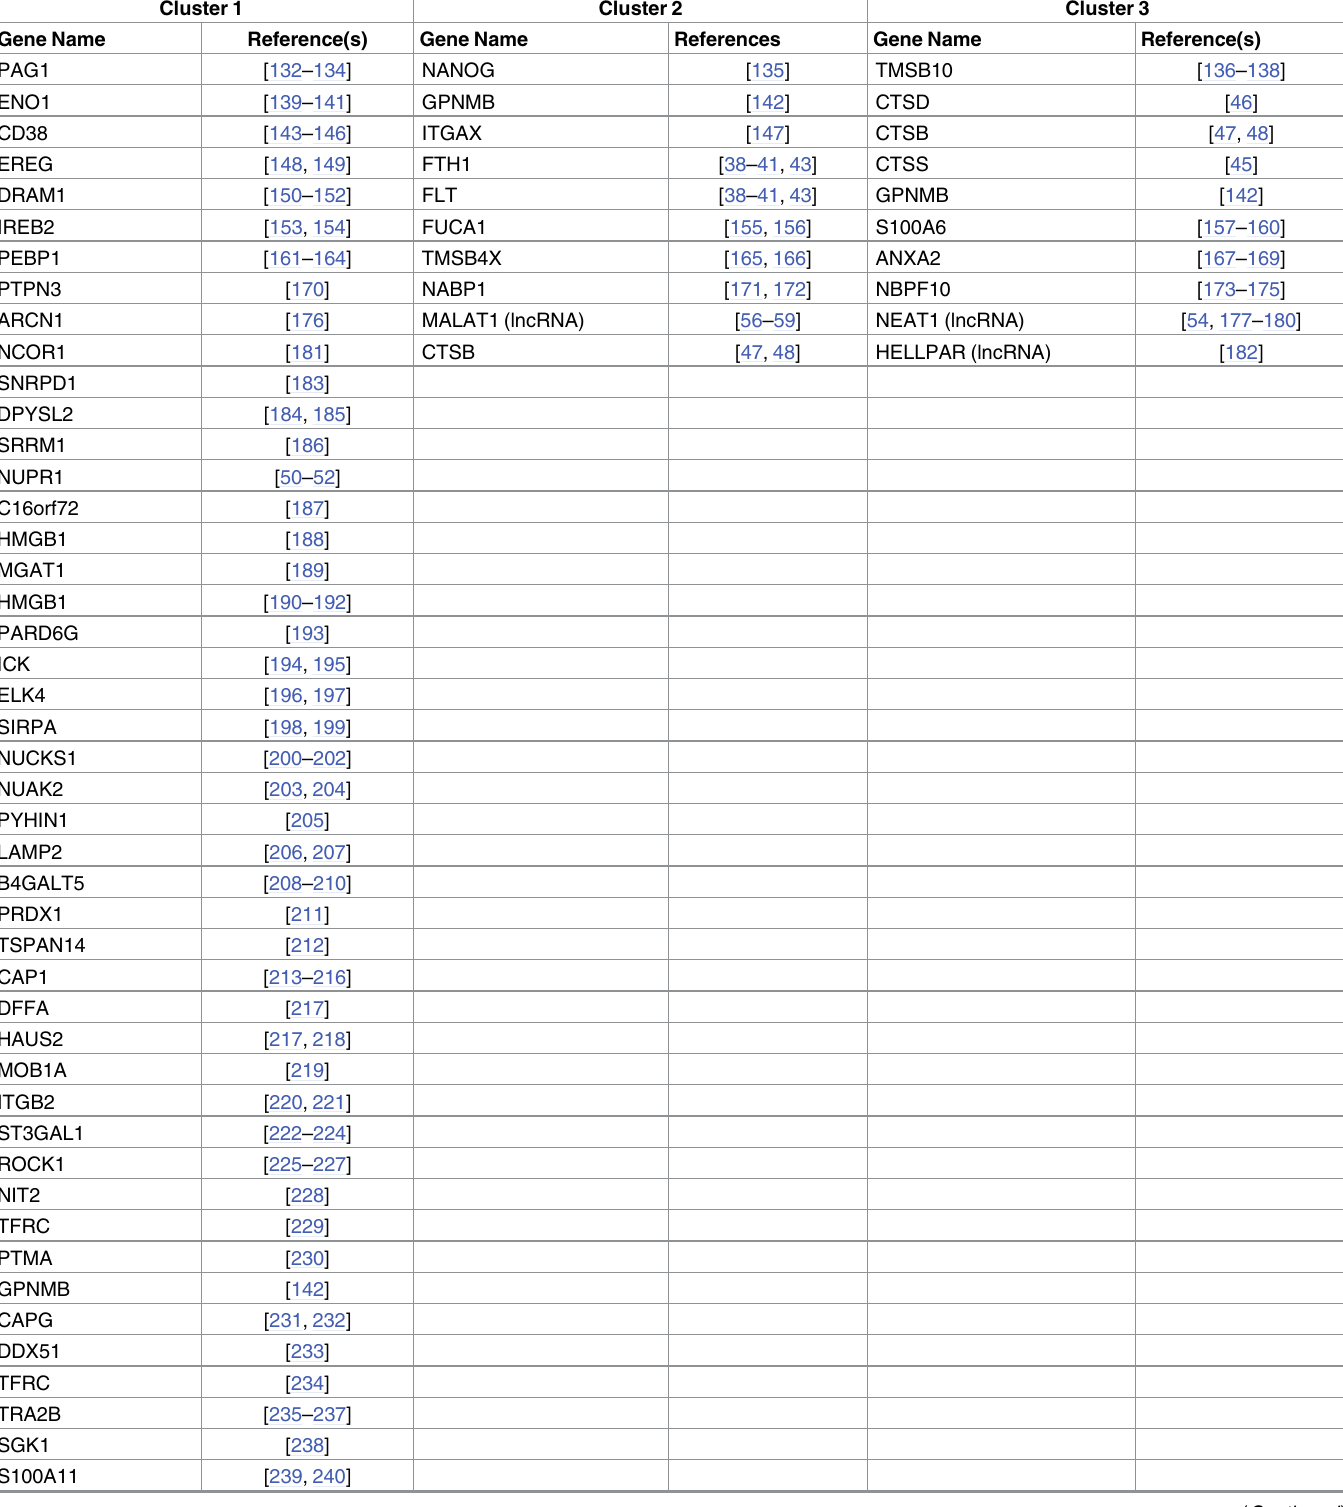
Table 1. Cancer-relatedgenes of